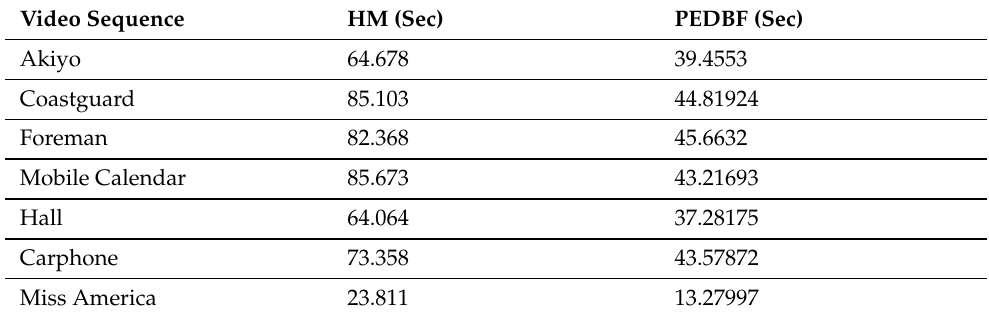
Table 3. Processing time of QCIF video sequences with QP = 32.